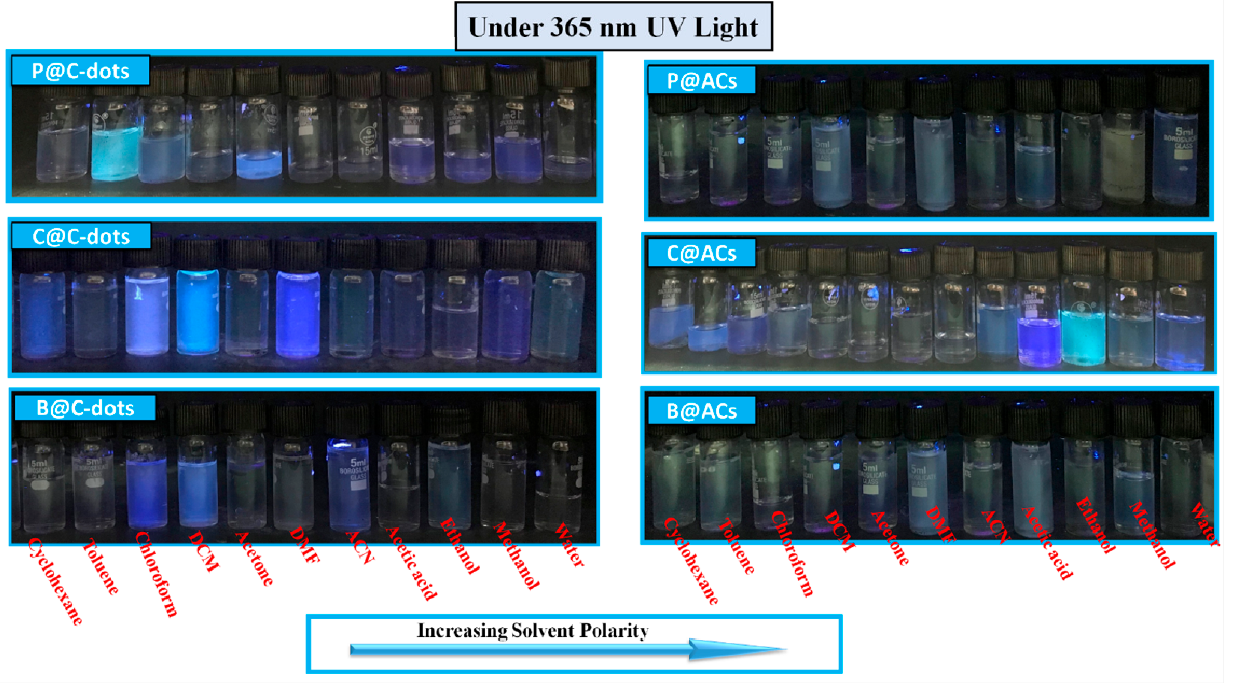
Figure 7. The digital images under UV light exposure for C-dots along with their counterpart ACs in presence of different solvents.